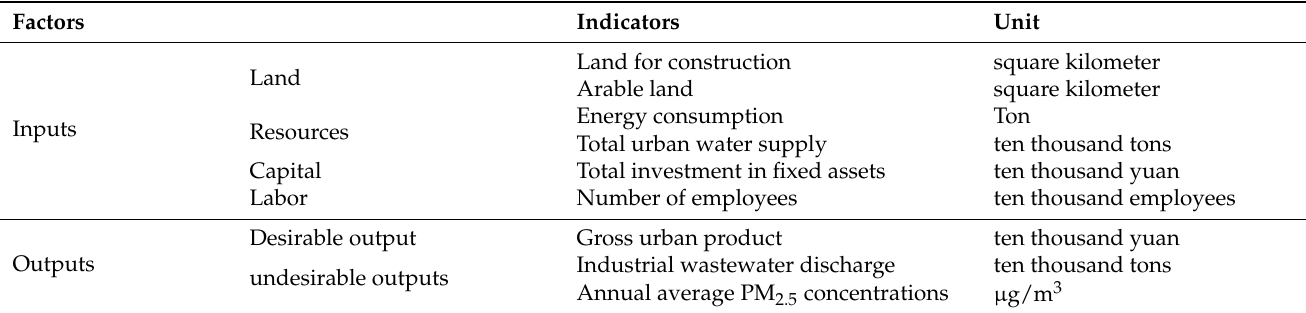
Table 1. Indicators for GTFP